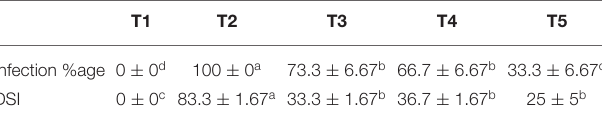
TABLE 2 | Effect of isolates on infection percentage and disease severity